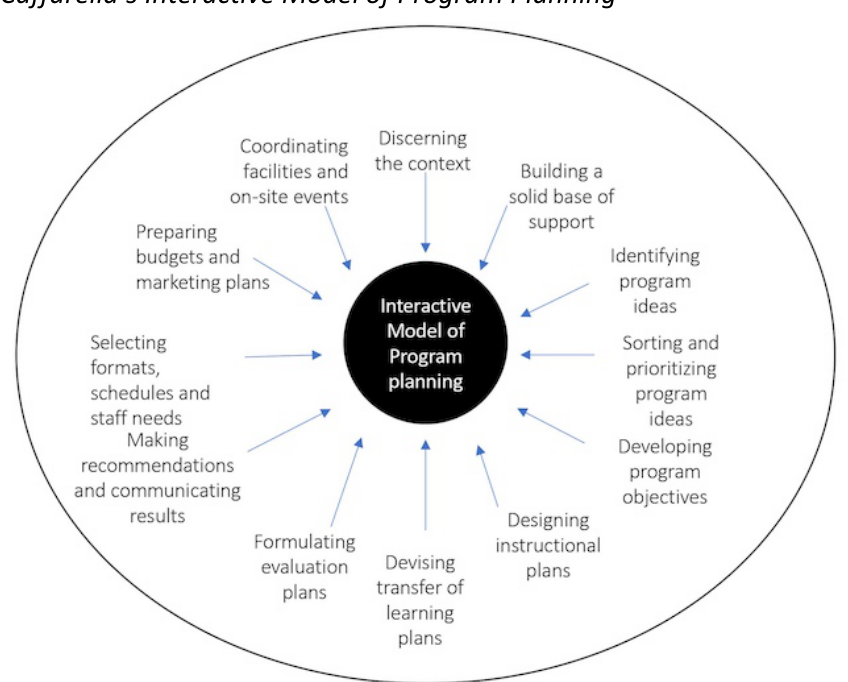
Caffarella’s Interactive Model of Program